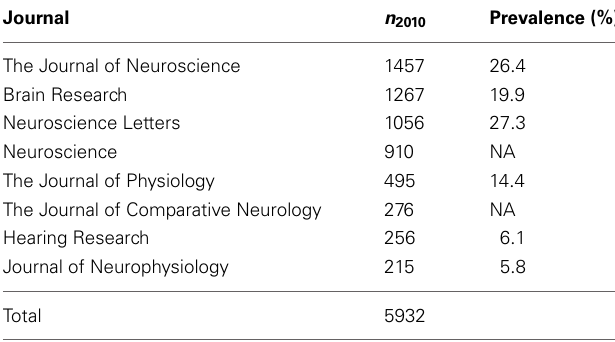
n 2010 denotes the number of 2010 publications associated with that journal. The prevalence column denotes the percent representation of that journal in the final data set. Two journals—Neuroscience, and The Journal of Comparative Neurology, are not represented in the final data set, as we were unable to download their